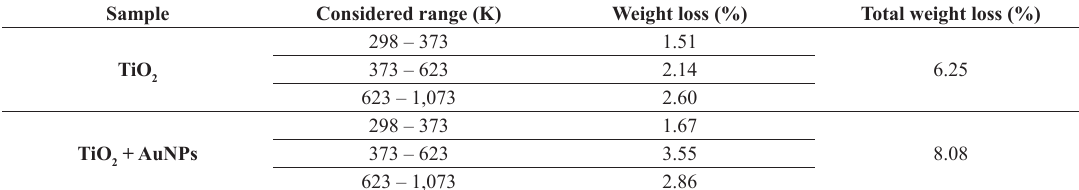
Table 5. Mass loss data obtained from thermogravimetric analysis for pure and gold nanoparticle TiO (AuNPs). Sample